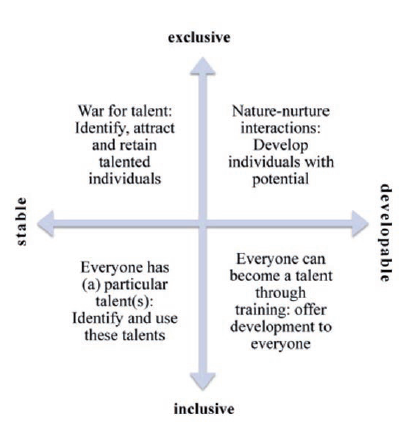
Fig. 1 – Talent Management Philosophies. Source: Meyers and van Woerkom